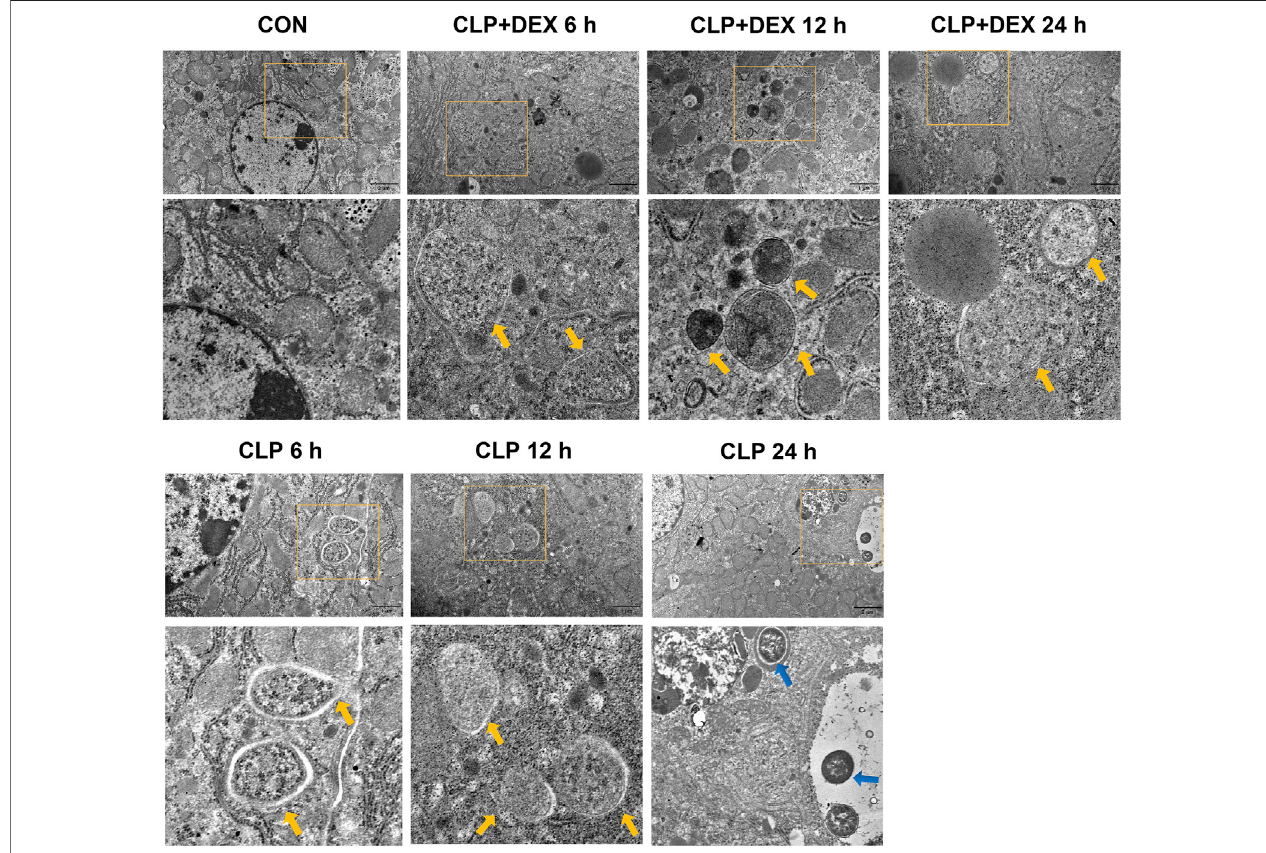
FIGURE 4 | Effect of DEX on the ultrastructure of liver tissues in CLP-induced mice. Autophagosomes in the liver cells are marked by yellow arrows; bacteriain the liver are marked by blue arrows.